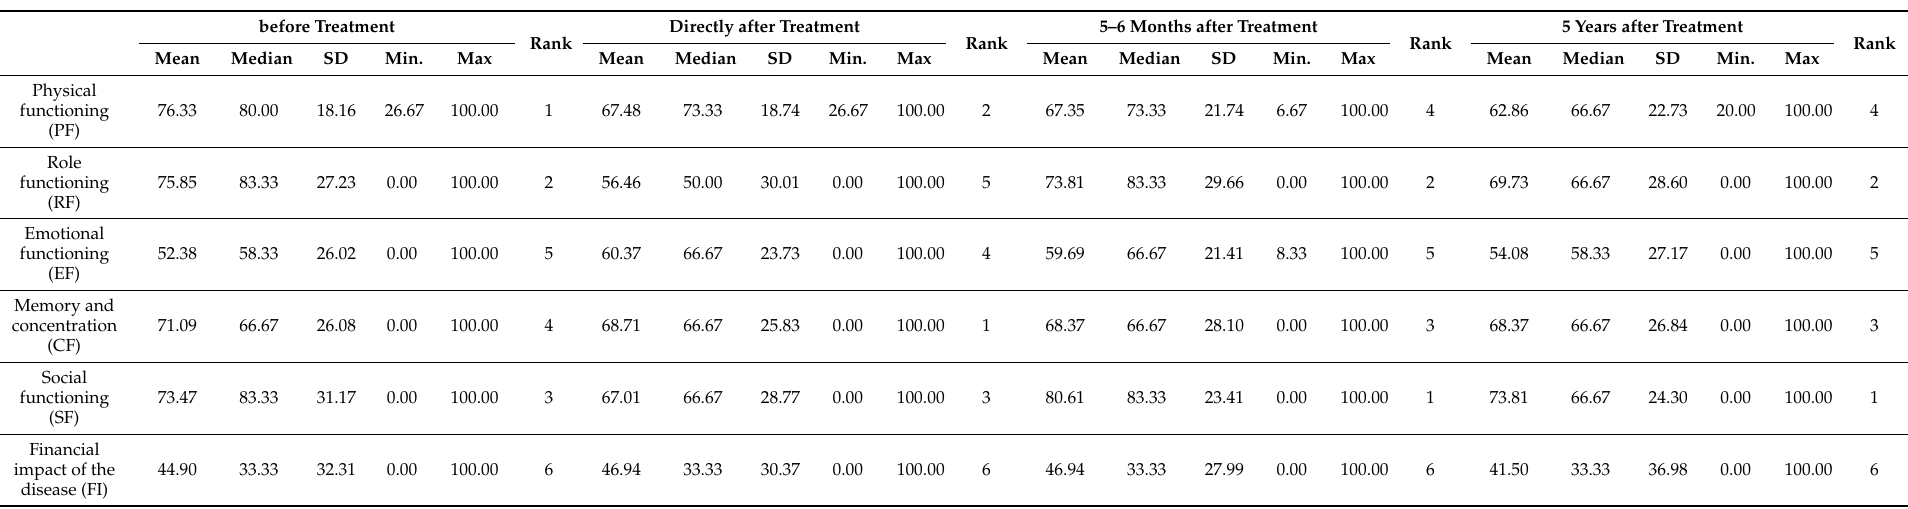
Table 5. Mean functional subscale values with rank determination.